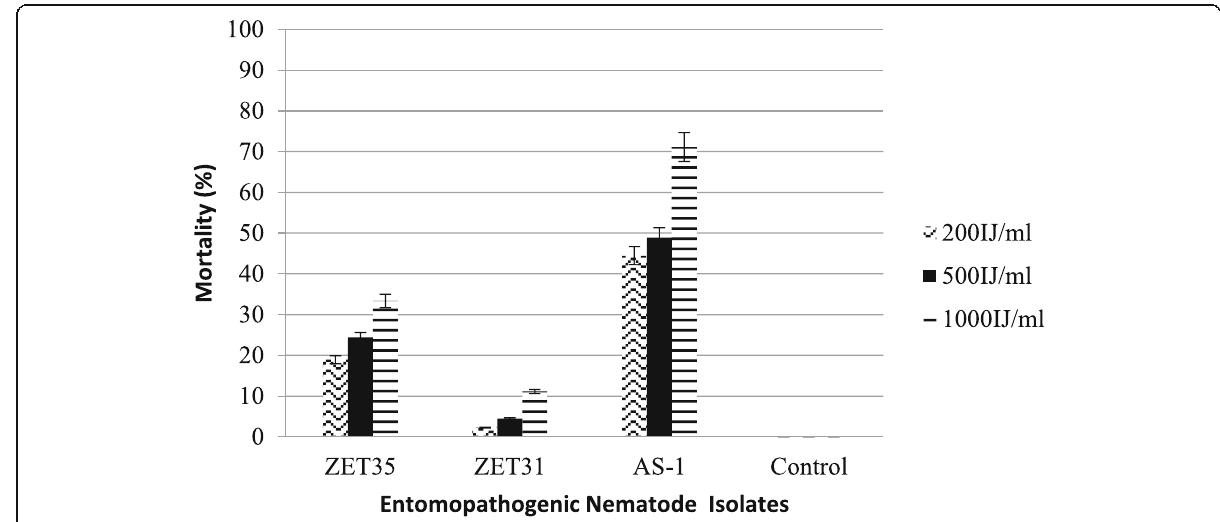
Fig. 2 Efficacy of H. bacteriophora (ZET35), S. feltiae (ZET31), and S. websteri (AS-1) on adults of the alder leaf, A. alni beetle at 25 °C